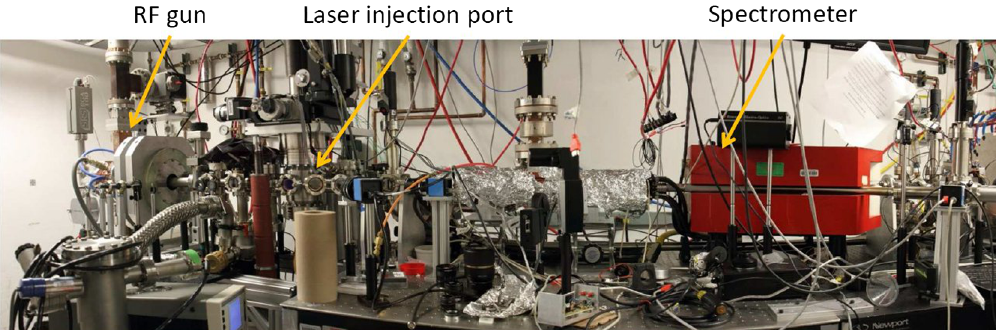
FIG. 15. Pegasus beam